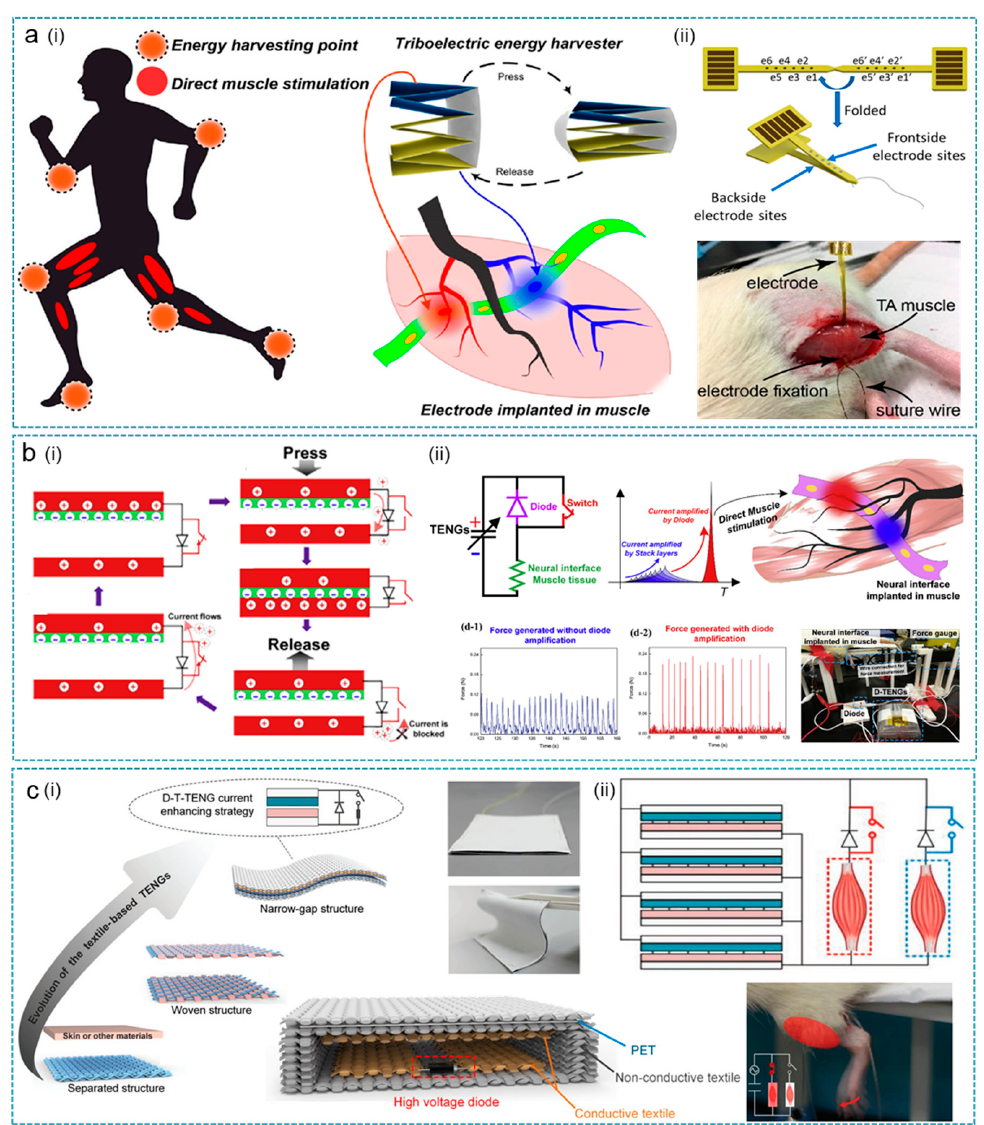
Figure 7. TENGs for muscle stimulation. ( a ) Direct muscle stimulation using a stacked-layer TENG and a multi-channel intramuscular electrode. The working principle (i) and in vivo experiment (ii) of the TENG using directly for muscle stimulation. Reprinted with permission from Ref. [177]. Cop- yright 2019 American Chemical Society. ( b ) Muscle stimulation method using a switching operation TENG to achieve higher efficiency. (i) Device working principle. (ii) The current amplified principle during muscle stimulation. Reprinted with permission from Ref. [108]. Copyright 2019 Elsevier. ( c ) A soft fabric-based thin-film TENG for selective and controllable muscle stimulation. (i) The fabri- cation process (i) and working principle (ii) of the thin-film TENG. Reprinted from Ref. [178]. Cop- yright 2019 John Wiley & Sons. Along with the neural interface optimization, the performance-enhancing strategy of TENGs has also been proposed to improve muscle stimulation efficiency. Wang et al. re- ported a new TENG configuration, called diode-amplified TENG (D-TENG), with en- hanced TENG outputs for direct muscle stimulation using a similar multi-channel neural interface (Figure 7b) [108]. As indicated, the D-TENG integrates a diode and a switch on the original stacked-TENG; thus, charges can be released instantaneously, generating a higher output current with uni-polarity (~40 μ A). In vivo demonstrations show that the